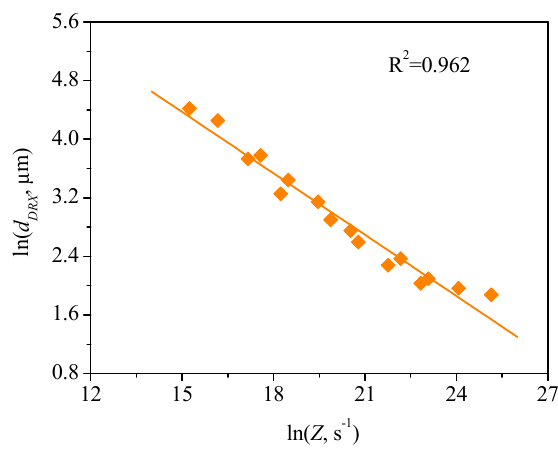
Figure 16. Relationship between d DRX and Zener –Hollomon parameter ( Z ).